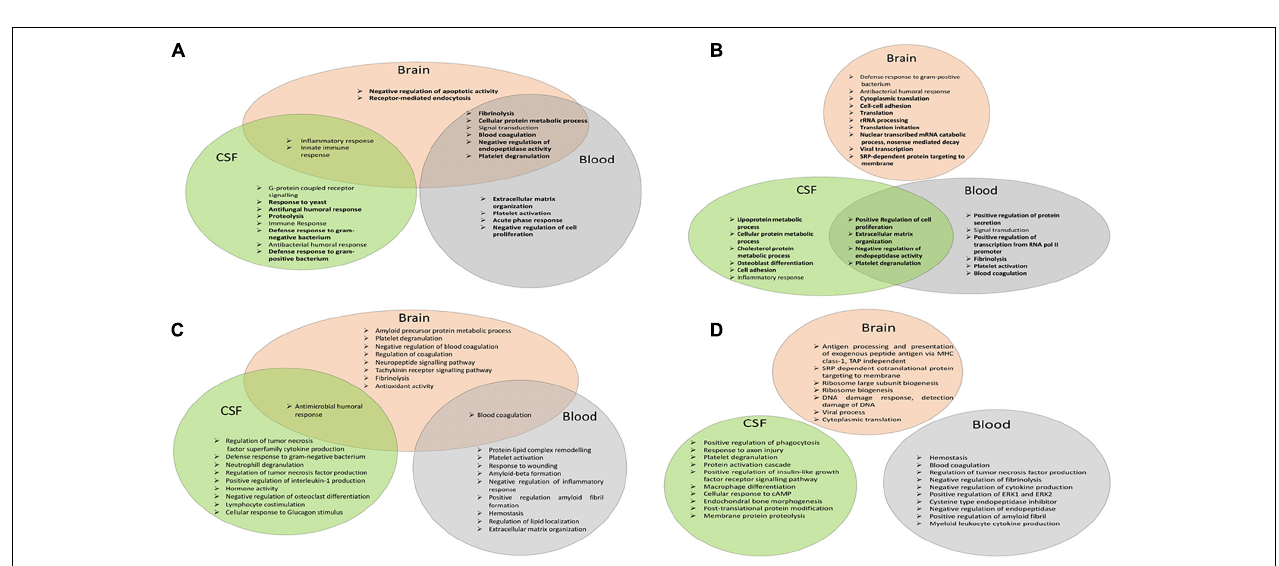
FIGURE 4 | Functional analysis of the network of AMPs characteristic of AD. (A) Venn diagram of the top 10 enriched GO terms according to DAVID for AMPs increased in the brain, CSF, or blood. (B) Venn diagram of the top 10 enriched GO terms according to DAVID in case of AMPs decreased in the brain, CSF, or blood. (C) Venn diagram of the top 10 enriched GO terms according to ClueGO for AMPs increased in the brain, CSF, or blood. (D) Venn diagram of the top 10 enriched GO terms according to ClueGO for AMPs lowered in the brain, CSF, or blood.